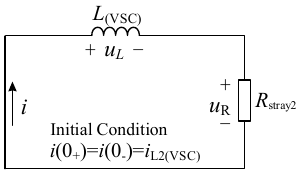
Figure 6. Equivalent circuit of the second stage discharge circuit of VSC.